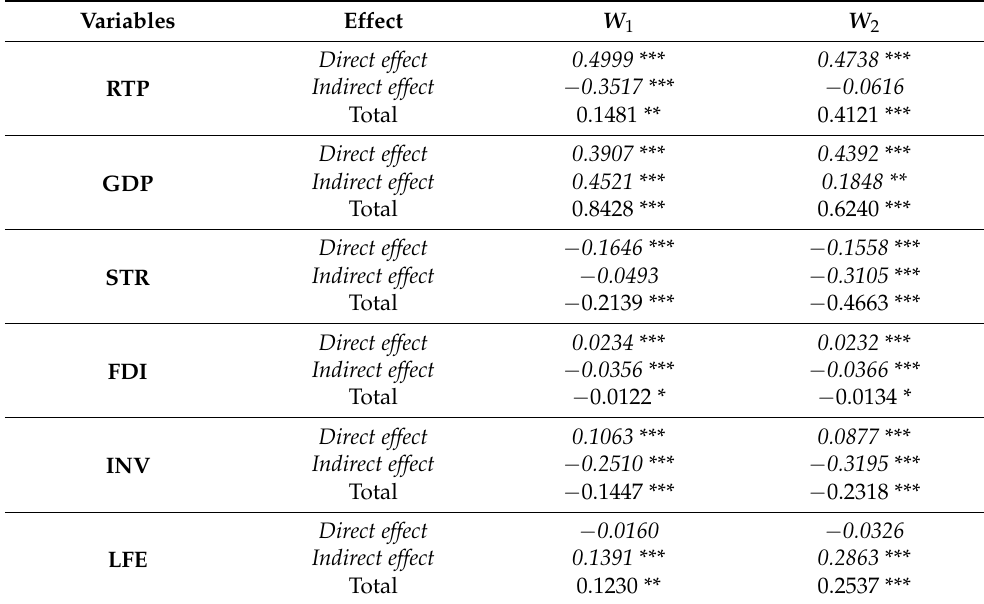
Table 9. Statistical data of the direct, indirect, and total effects of explanatory variables.